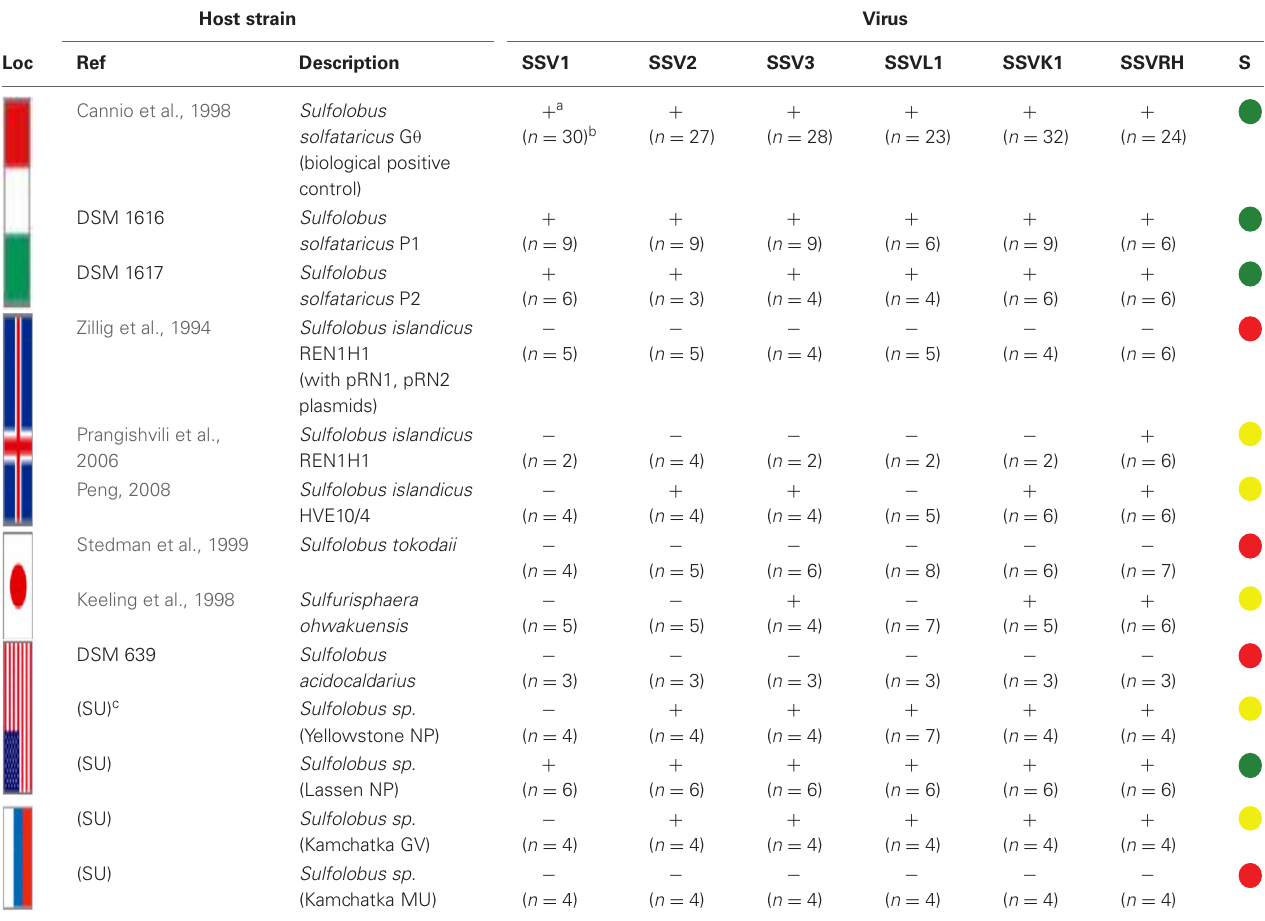
Table 1 | Infectivity/susceptibility